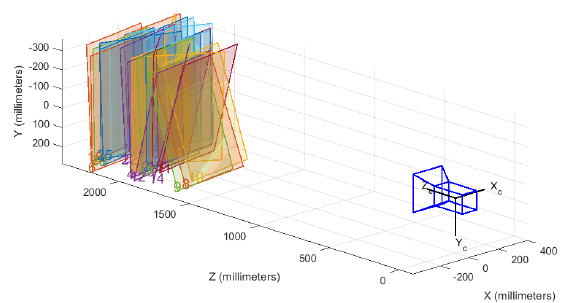
Figure 4. Diagram of camera calibration Focal length Principal point